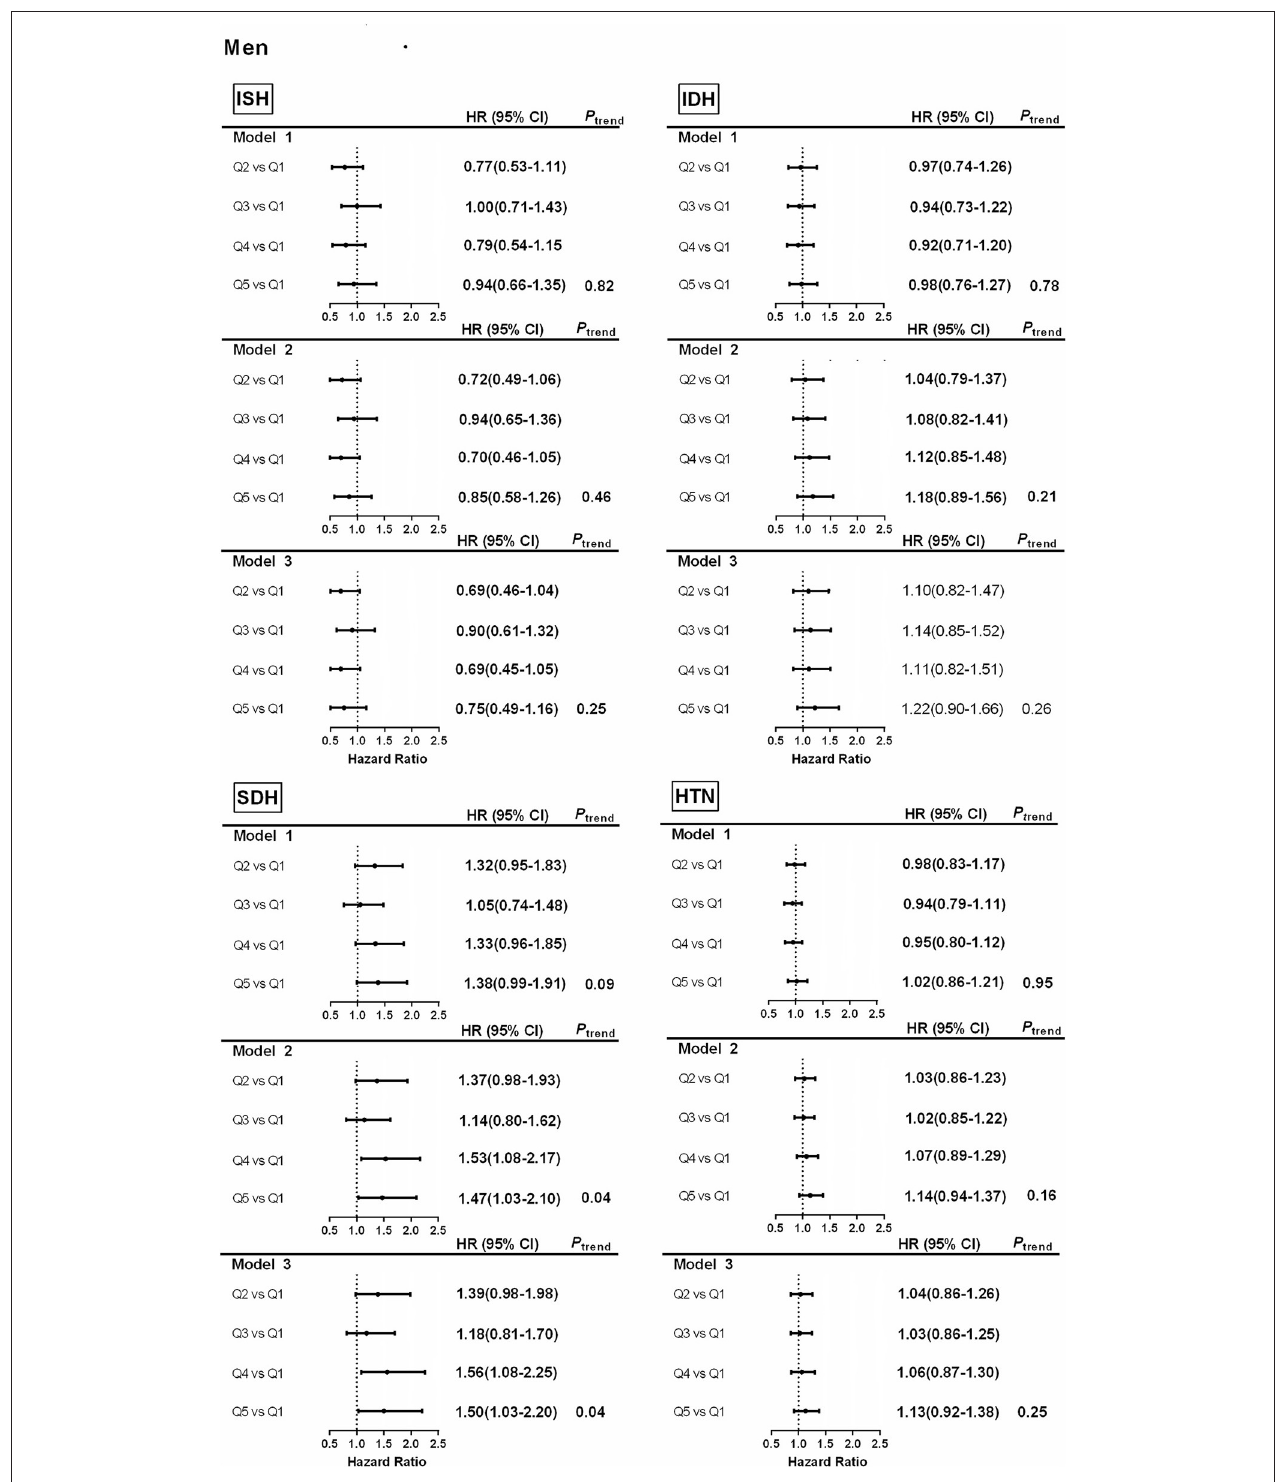
FIGURE 3 | Associations between percentage energy from carbohydrate by quantiles and hypertension and subtypes in men. Model 1. Hazard ratios and 95% CIs are adjusted for age. Model 2. Hazard ratios and 95% CIs are adjusted for age, urban or rural location, education level, waist circumference, ever smoking (never, ever), alcohol drinking (abstainer or drinker), personal income, BMI (underweight, normal weight, overweight, and obesity). Model 3. Hazard ratios and 95% CIs are adjusted for age, urban or rural location, education level, waist circumference, ever smoking (never, ever), alcohol drinking (abstainer or drinker), personal income, BMI (underweight, normal weight, overweight, and obesity), physical activity and energy intake. ISH, isolated systolic hypertension; IDH, isolated diastolic hypertension; SDH, systolic–diastolic hypertension; HTN, hypertension.